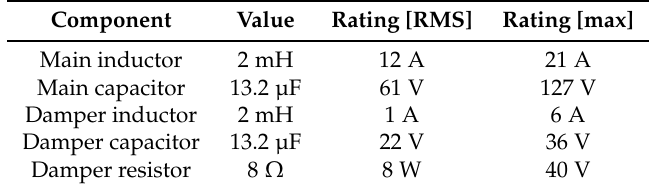
Table 2. Specifications of the output filter. The resulting cut-off frequency is 2212 Hz.